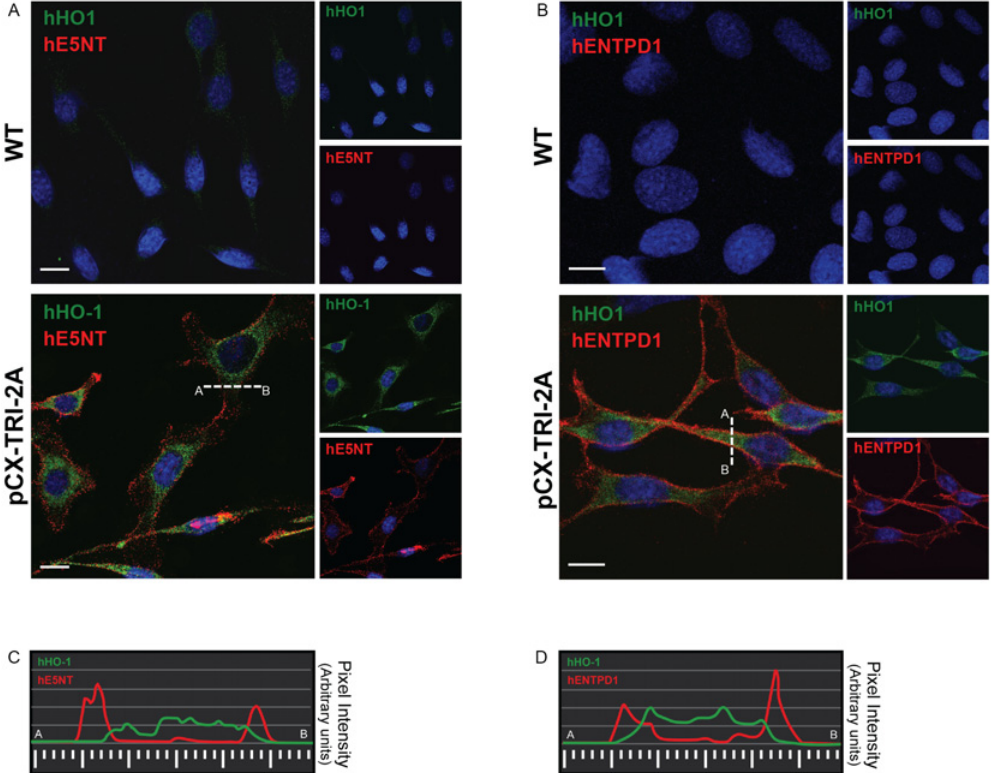
Fig 3. All the three exogenous proteins were correctly localized in pCX TRI 2A-transfected cells. WT and pCX-TRI-2A-transfected cells were co- stained with anti-hHO1 and anti-hE5NT antibodies ( A ) or with anti-hHO1and anti-hENTPD1antibodies ( B ). Transfected cells positive to hE5NT or hENTPD1 (red) were also positive to hHO1 (green). hE5NT and hENTPD1 localized on the cell surface, while hHO1 had a perinuclear and/or ER membranes cytoplasmic localization. ( C - D ) Plot of the signal intensity for hE5NT and hENTPD1 (red) and hHO1 (green) along the line drawn in A and B indicated that the most intense hE5NT and hENTPD1 signals are not colocalized with hHO1